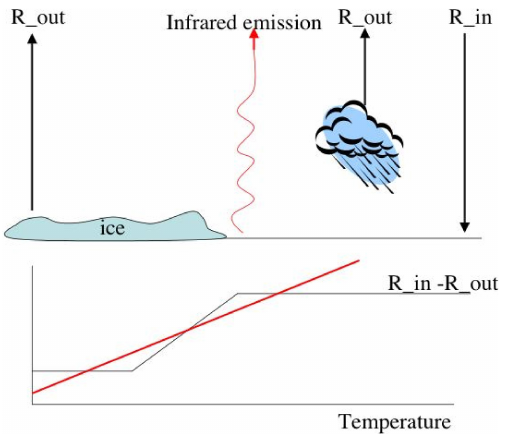
Fig. 1. The energy balance climate model. In the upper layer we show the basic variables of the model: the incoming radiation R in and the outcoming radiation R out and the infrared emission. In the lower panel we show the albedo as a function of temperature R in − R out = ( 1 − α(T ))R in . The thick line represents the infrared